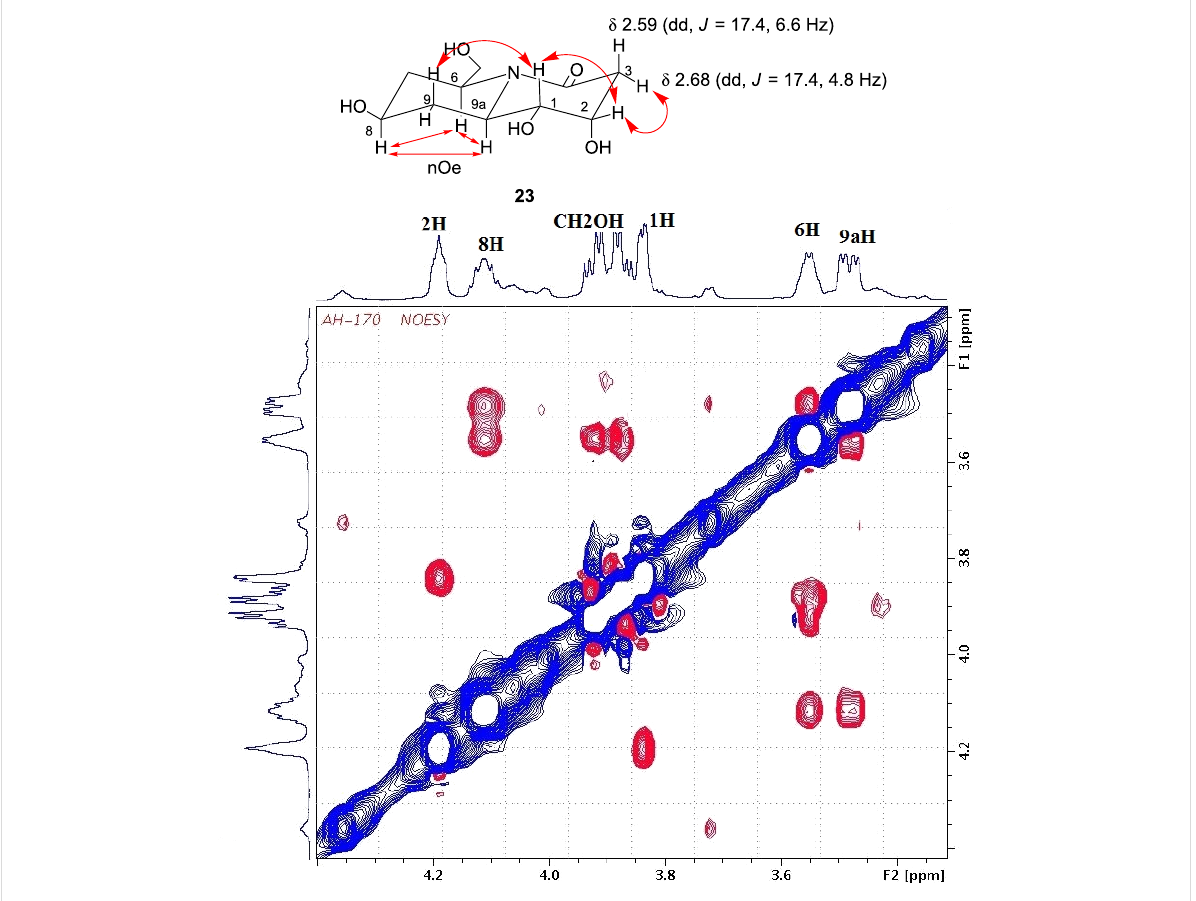
Figure 5: Selected nOe correlations and part NOESY spectrum of compound 23 in D 2 O (600 MHz).